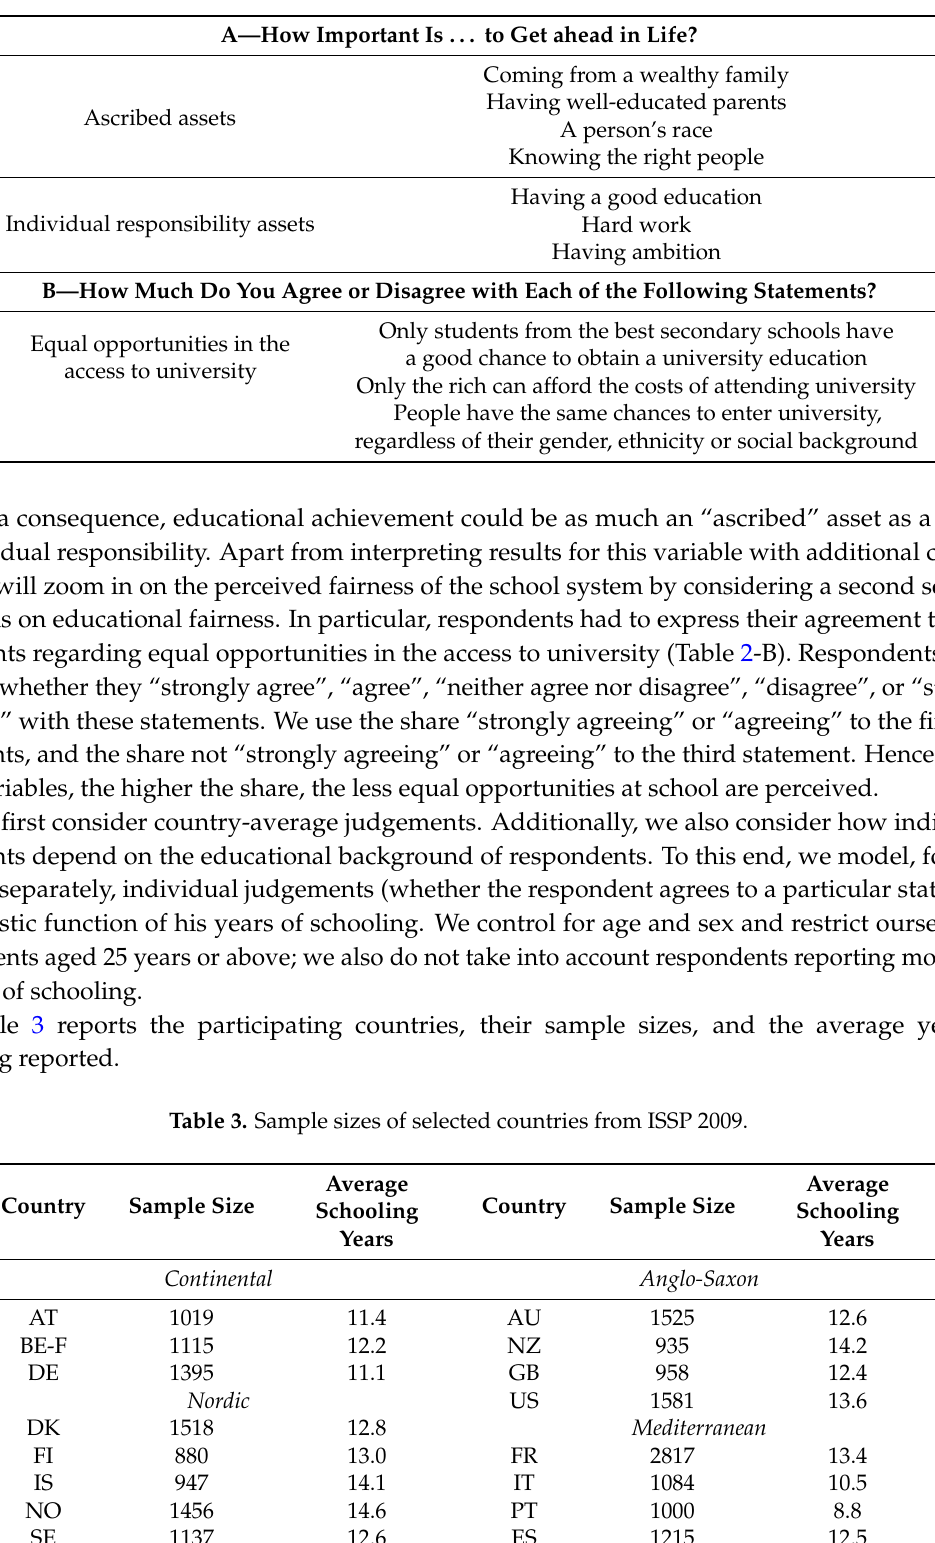
Table 2. Importance of various assets to get ahead in life, as surveyed in ISSP 2009.